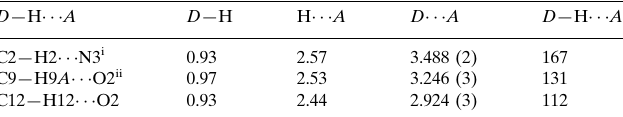
Hydrogen-bond geometry (A˚ , (cid:2)